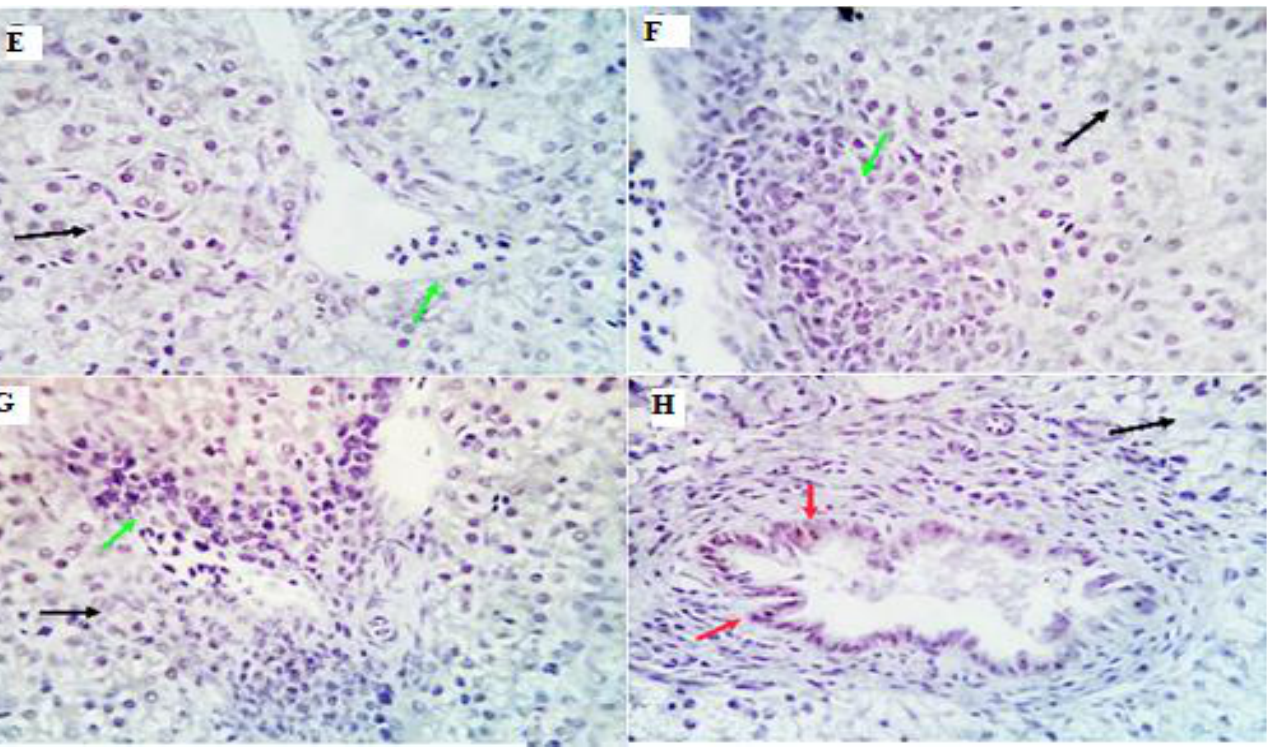
Figure 3. Immunostained positive TGF- β cells (red arrows) in the liver of different experimental chicken groups. ( E ): 0.08, ( F ): 0.45, ( G ): 0.93, and ( H ): 7.2% for LEO0, LEO200, LEO400, and LEO600 groups.